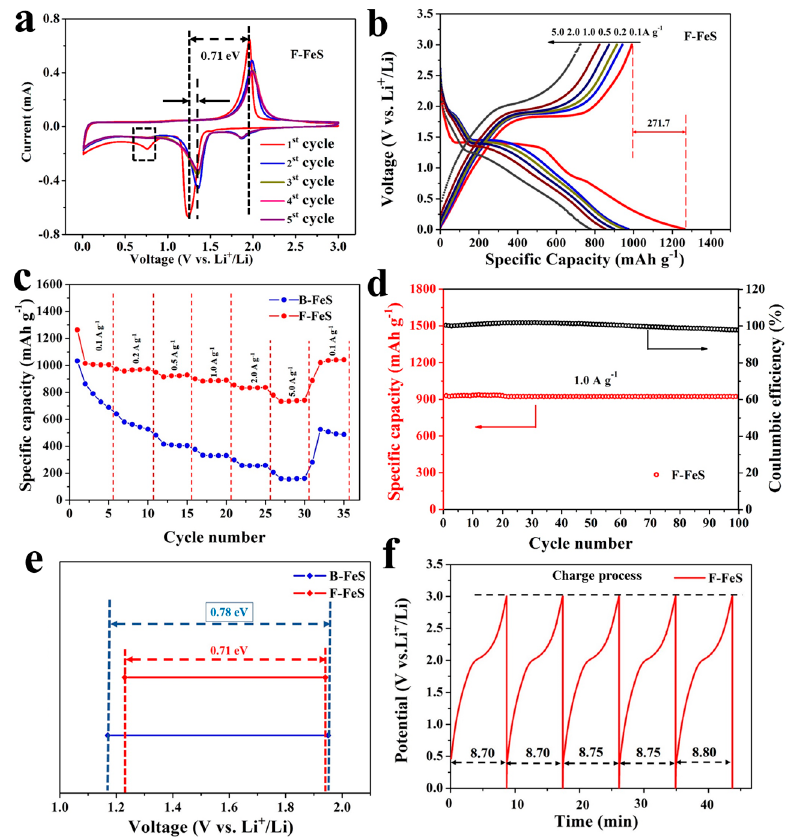
Figure 6. Kinetics investigation of the as-prepared 3D F-FeS nanostructure: ( a ) corresponding galvanostatic discharge/charge at various current densities and ( b ) rate performance; ( c ) long-term cyclic performance at the current density of 1.0 A g − 1 ; ( d ) CV curves at a scan rate of 0.1 mV s − 1 ; ( e ) potential difference between cathodic peak and anodic peak in cyclic voltammetry profile of the first cycle; ( f ) corresponding charge curves.